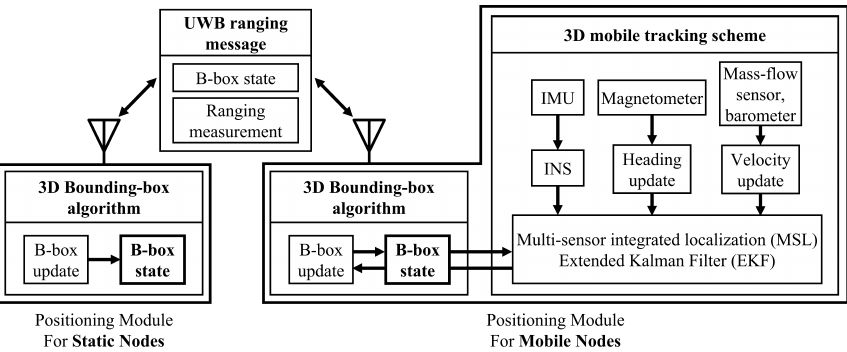
Figure 2. IR-UWB-based 3D multi-hop self-positioning with bounding-box and mobile track- ing scheme.